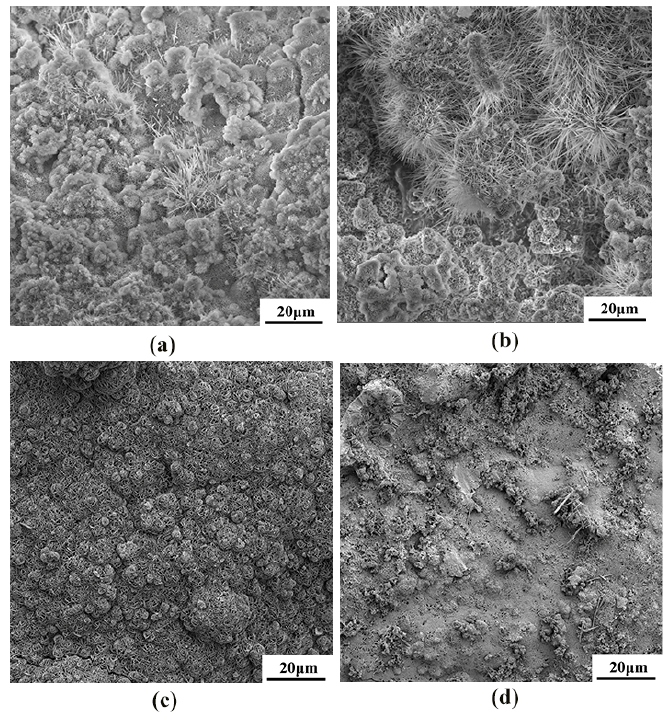
Figure 10. The SEM morphologies of the surface corrosion products on WE43 alloy after immersion for 7 days in Hanks’ solution: ( a ) as-cast, ( b ) cold-rolled, ( c ) warm-rolled, and ( d )